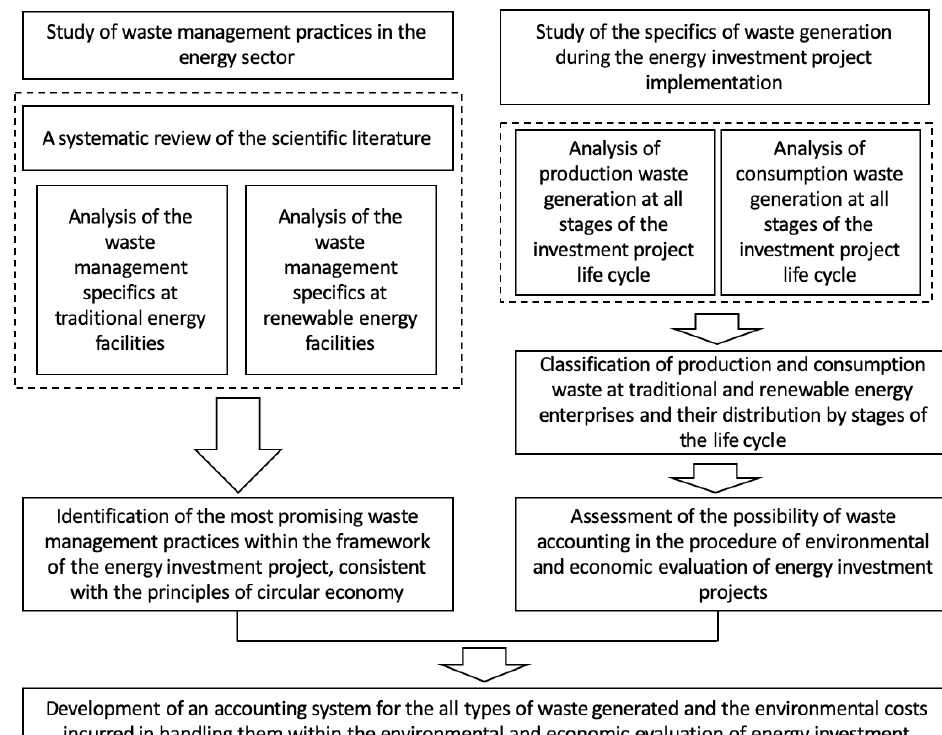
Figure 4. The logic of the research and its stages.